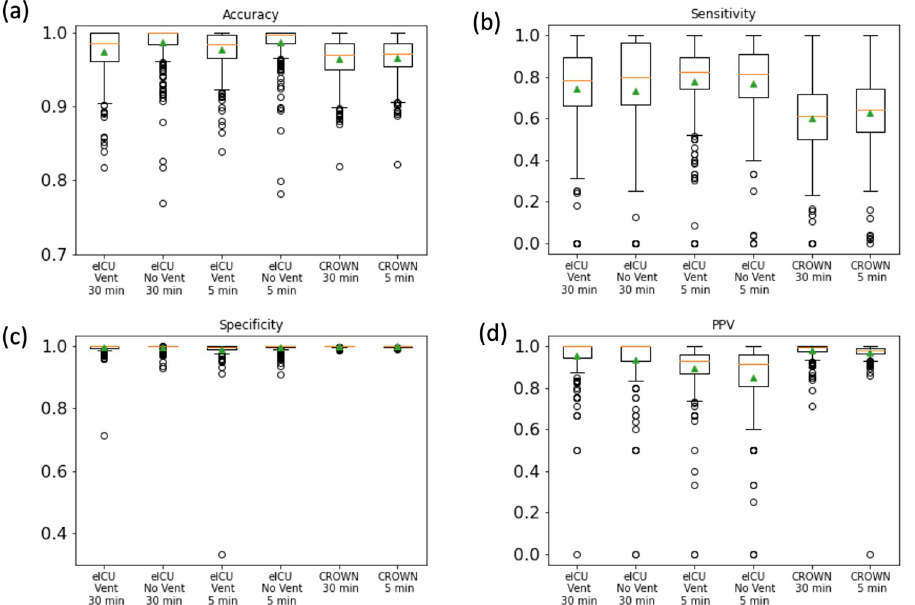
Fig 2. (a) Accuracy, (b) Sensitivity, (c) Specificity, and (d) PPV for SWIFT-5 and SWIFT-30 tested on eICU patients with and without ventilators, and JH-CROWN patients with COVID-19. In each box-and-whisker plot, the individual datapoints come from evaluation of the model on each of the test-set patients. The box extends from Q1 to Q3. The orange line represents the median value and the green triangle represents the mean value. The upper whisker extends to the highest value below Q3+1.5 � (Q3-Q1), and the lower whisker extends to the lowest value below Q1-1.5 � (Q3-Q1). Points beyond the whiskers are considered